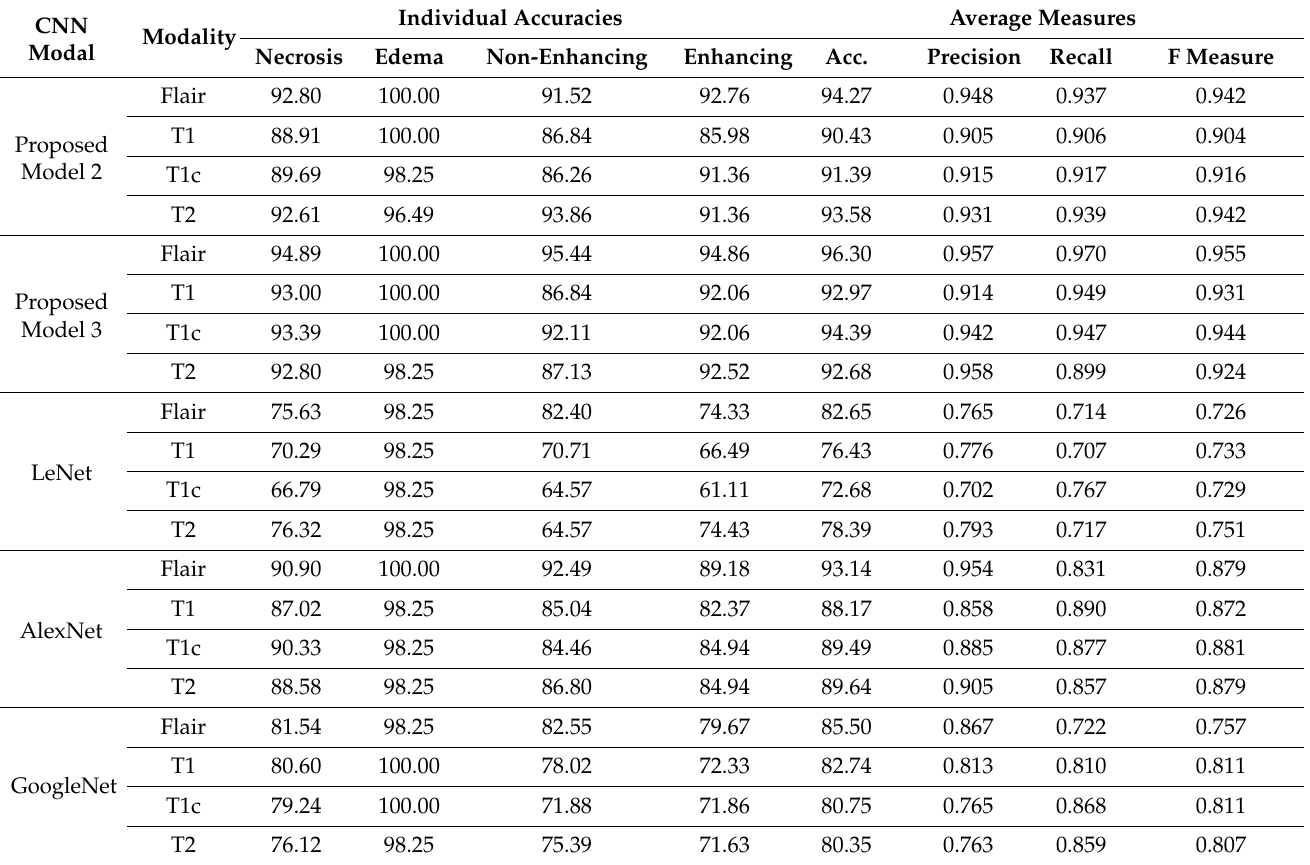
Table 13. Multiclass Glioma Tumor Classification results using proposed CNN models classifiers compared with other well-known CNN models for brain LGG MR images.